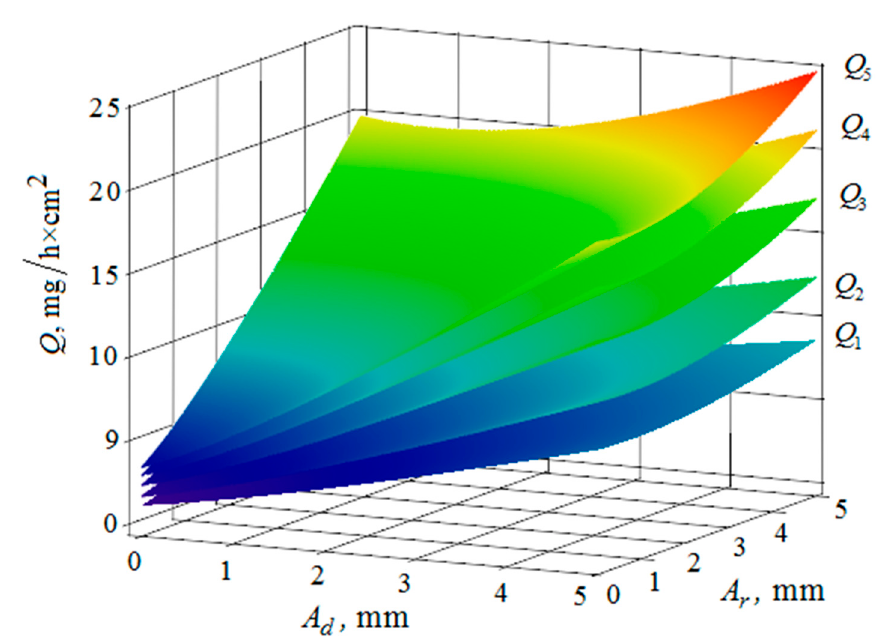
Figure 20. Dependence of the metal removal Q , mg/h·cm 2 on the amplitudes of oscillations Ar , mm and Ad , mm of the reservoir working surfaces and the processed part for different values of diameters of the abrasive granules: ( 1 Q , 2 Q , 3 Q , 4 Q , 5 Q —metal removal at d = 10; 15; 20; 25; 30 , mm); the frequencies of oscillations of the reservoir r ω working surfaces and the part d ω surface 50 Hz.